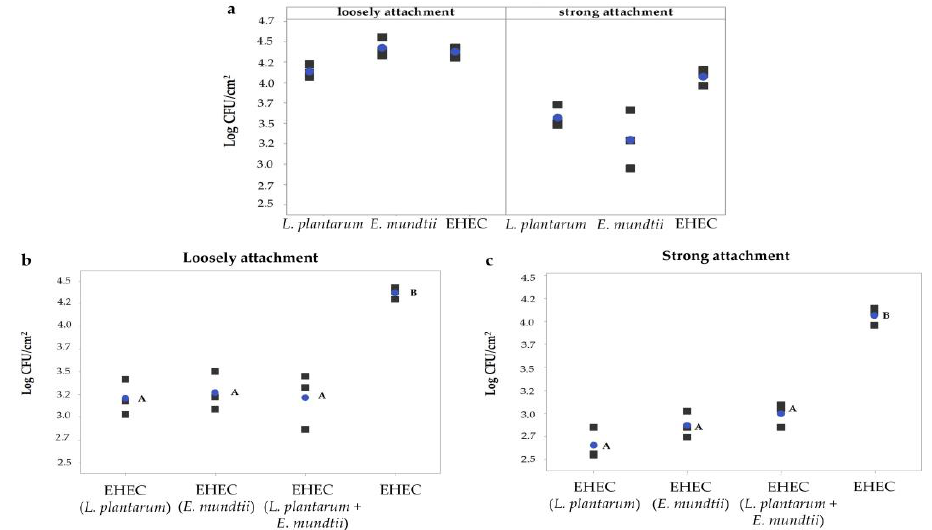
Figure 5. Cells counts of EHEC ( E. coli O157:H7 NCTC12900) and LAB ( L. plantarum CRL681; E. mundtii CRL35) adhered to meat. ( a ) Strong and loose attachment of single strains on meats discs; ( b ) performance of EHEC in the presence of LAB during loose attachment; ( c ) performance of EHEC in the presence of LAB during strong attachment. The blue dots represent the mean value, and the grey squares represent each independent experiment value. Different letters indicate statistically significant differences between the groups ( p < 0.05).